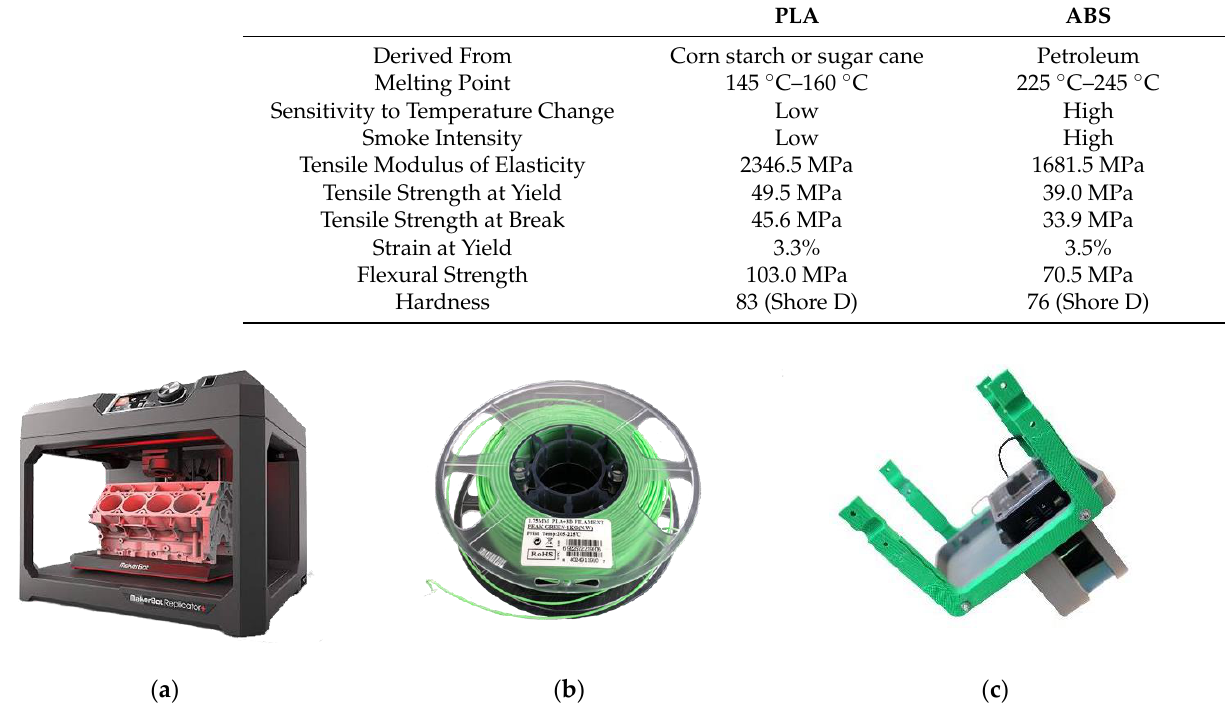
Figure 4. ( a ) Makerbot Replicator Plus printer; ( b ) PLA filament roll; ( c ) printed